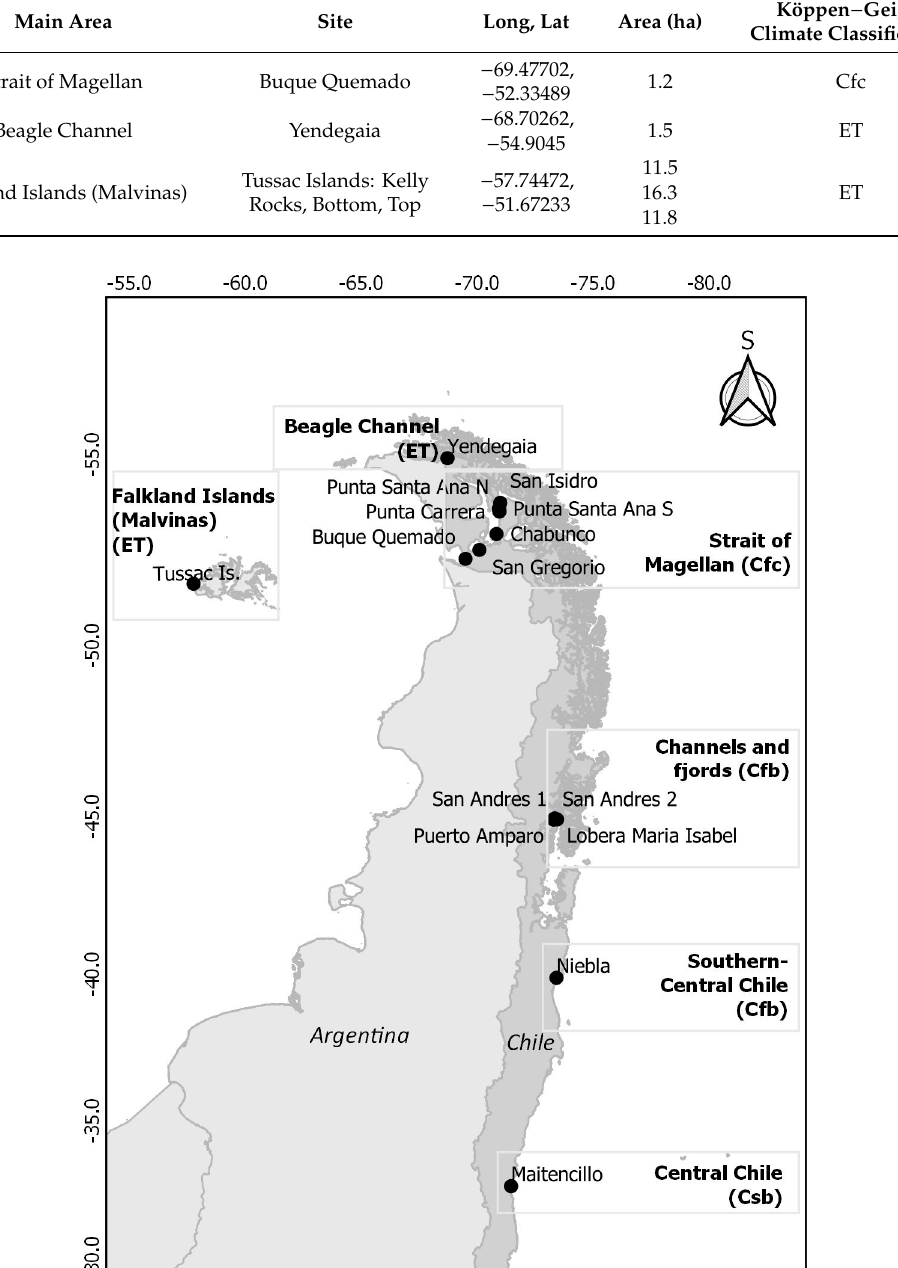
Figure 3. Map of the surveyed sites for validation at a high resolution of giant kelp forests. Cartographic projection EPSG: 3857. Maps in this article are south-oriented to highlight the connectivity of giant kelp forests at Sub-Antarctic latitudes.